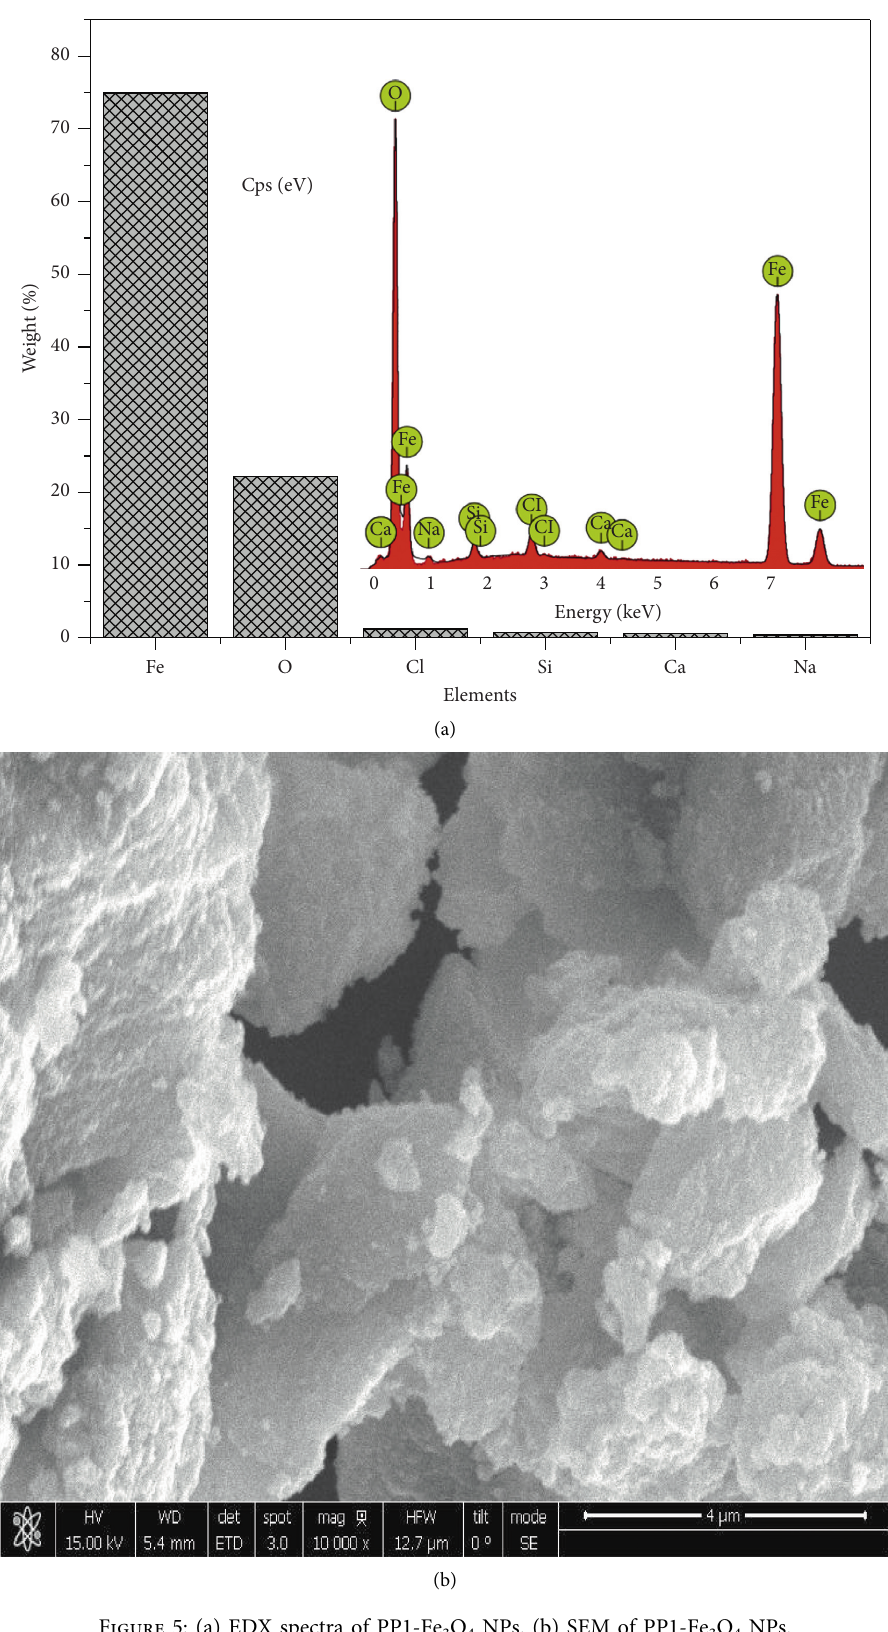
Figure 5: (a) EDX spectra of PP1-Fe 3 O 4 NPs. (b) SEM of PP1-Fe 3 O 4